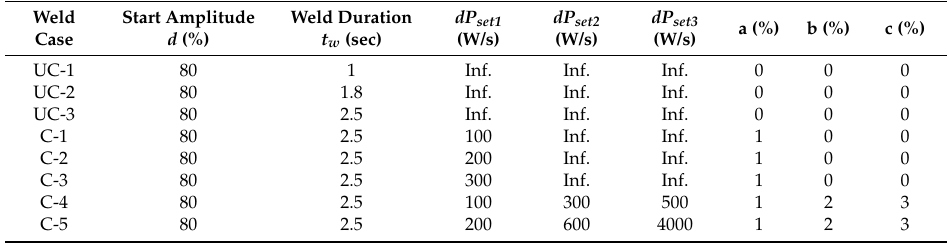
Table 1. Weld parameters used for the experimental analysis of the uncontrolled and the controlled ultrasonic spot welds (the represented parameters are taken from the control algorithm in Figure 4). dP set1 dP set2 dP set3 Weld Start Amplitude Weld Duration a (%) b (%) c (%) d (%) t w (sec) Case (W/s) (W/s) (W/s) UC-1 80 1 Inf. Inf. Inf. 0 0 0 UC-2 80 1.8 Inf. Inf. Inf. 0 0 0 UC-3 80 2.5 Inf. Inf. Inf. 0 0 0 C-1 80 2.5 100 Inf. Inf. 1 0 0 C-2 80 2.5 200 Inf. Inf. 1 0 0 C-3 80 2.5 300 Inf. Inf. 1 0 0 C-4 80 2.5 100 300 500 1 2 3 C-5 80 2.5 200 600 4000 1 2